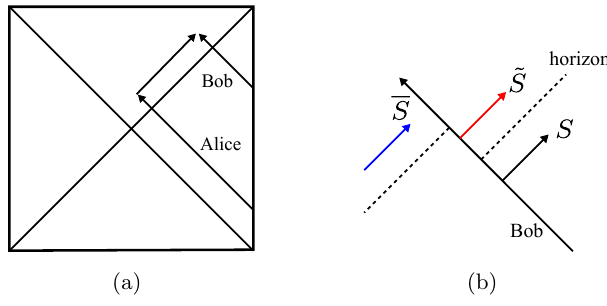
Figure 6 . (a) A setup by Hayden and Preskill. Alice sends a signal to Bob. (b) A re(cid:12)nement of the Hayden-Preskill argument. Alice’s signal does not reach Bob due to